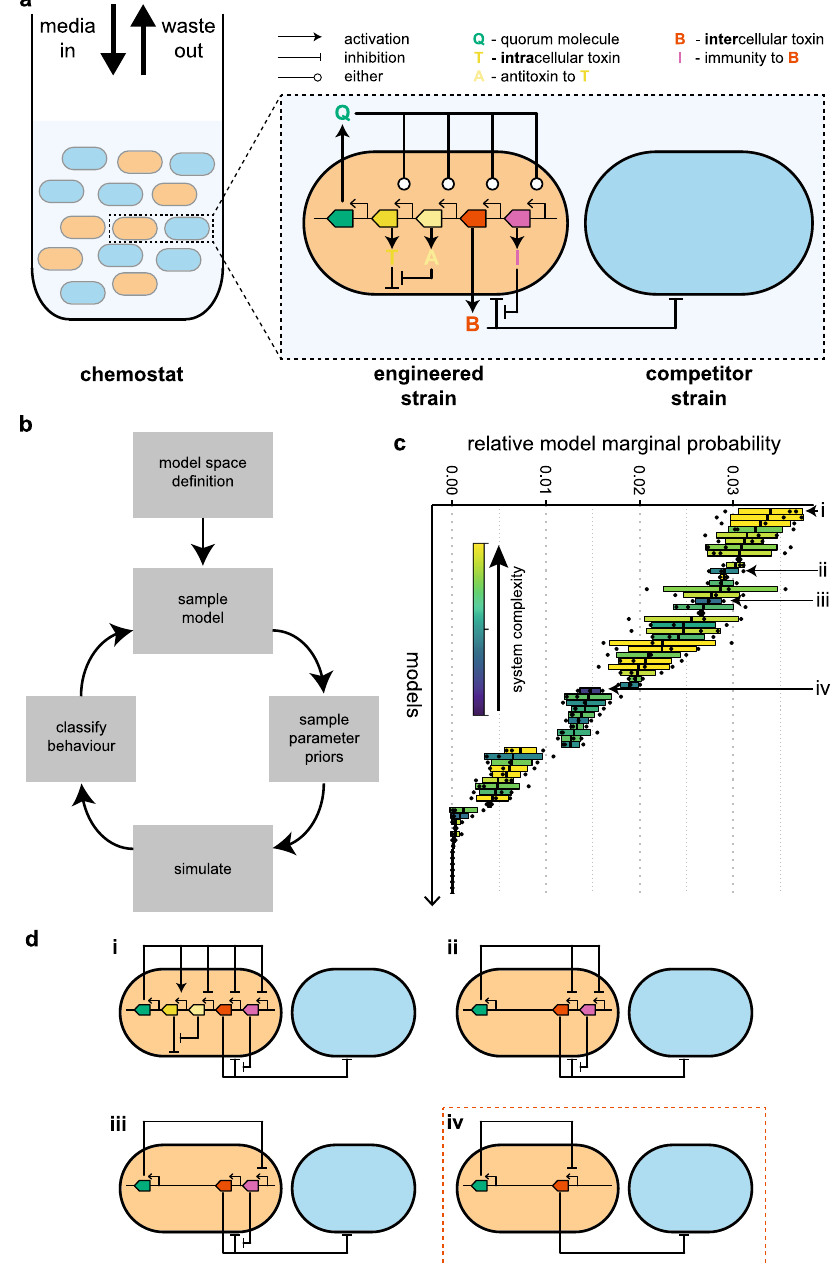
Fig. 9 Exploring the space of possible models of population control to fi nd the best system. a Schematic of all possible components for single strain engineering. The engineered strain can produce an intercellular toxin and its antitoxin and an intracellular toxin and its antitoxin. All of these can be positively or negatively regulated by a self-produced quorum molecule, allowing density-dependent control of the engineered cell ’ s actions. b Once the model space has been de fi ned, we explore it using ABC SMC to determine which models with which parameters are capable of producing stable coexisting populations. c The ordered model marginal posterior probabilities. The long tail of extinct models has been trimmed. The boxes for each model are coloured according to the model ’ s complexity; models with a larger number of parameters are closer to the yellow and fewer parameters are close to blue. d The best system (i) requires control over the expression of four genes. Systems that do not require intracellular toxin or immunity perform well for their level of complexity (ii – iv). In fact, the simplest system able to produce stable co-existence is the system that we have developed (iv). In c , each box is centred at the mean, with the left and right edges showing the standard deviation, of three replicates, each containing 18,000 particles. Black points show the outcome of each rather than just qualitative sensors, the population size of the engineered strain at a target location. Delivery of therapeutics by engineered bacteria requires even more con fi dence in the dynamics of the engineered population in order to prevent over- or under-dosing 18 .